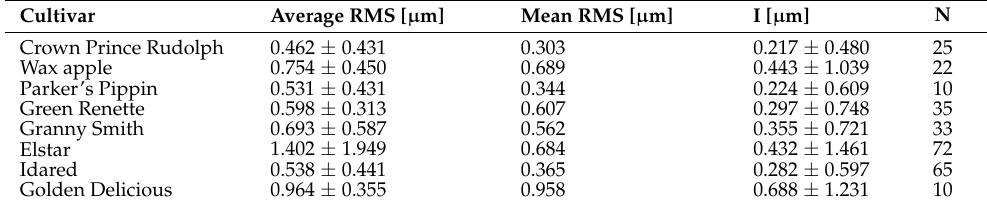
Table 1. Root mean square (RMS) roughness of all cultivars measured on the equatorial region, I-interval between 25% and 75% of measured values, N- number of measurements.